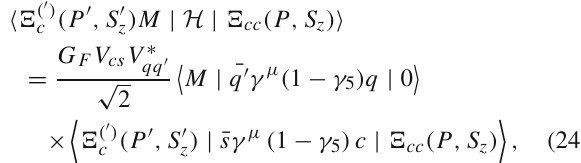
Table 6 Widths (in unit 10 10 s − 1 ) of non-leptonic decays (cid:2) cc → (cid:2) ( Mode